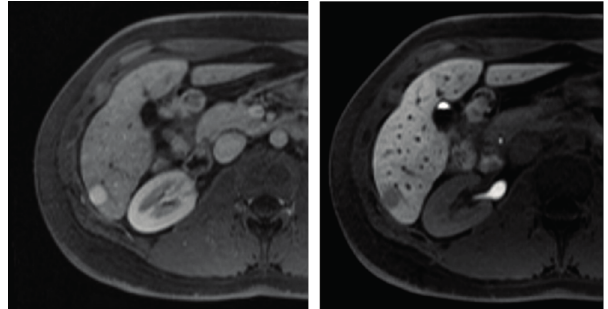
Figure 6. Typical MR imaging features of HCC using hepatocyte specific contrast